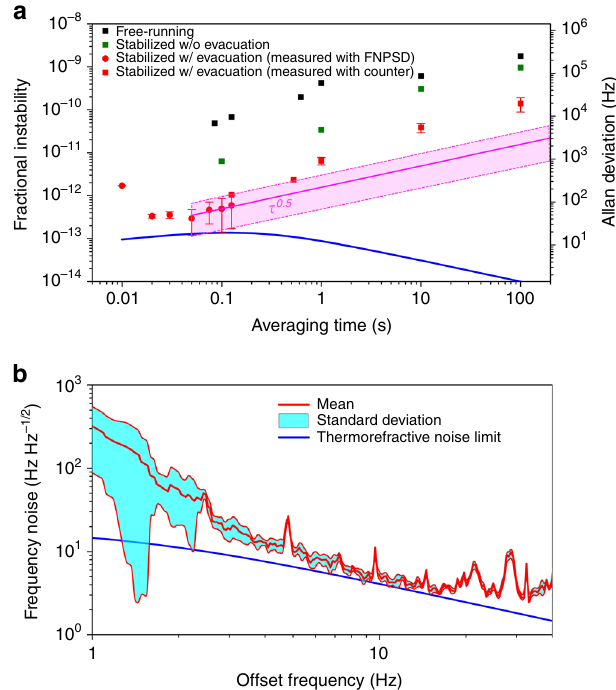
Fig. 4 Fractional frequency instability measurements. a Measured fractional frequency instabilities (FI) of the beat frequency between the Fabry-Pérot (FP) cavity reference laser and the free-running laser ( squares in black ), and the beat frequency between the reference laser and the laser stabilized to the WGM resonator without evacuation ( squares in olive ), respectively. The P n Þ and standard deviation red squares and bars are the mean ð μ ¼ n (cid:2) 1 ffiffiffiffiffiffiffiffiffiffiffiffiffiffiffiffiffiffiffiffiffiffiffiffiffiffiffiffiffiffiffiffiffiffiffiffiffiffi i ¼ 1 FI I ð σ ¼ Þ of the frequency instability of the laser stabilized to the resonator calculated from 10 sets of frequency counting data at 1 s averaging time, respectively, measured with a frequency counter where n is the number data set. The red circles and bars are μ and σ of the frequency instability of the laser stabilized to the resonator derived from the 74 frequency noise power spectral density (FNPSD) measurement traces. The magenta area represents the expected Allan deviation bound imposed by random walk frequency noise. b The noise statistics of 74 FNPSD traces. The red curve is the mean value and the cyan area is the connected standard deviations. The blue line is the thermorefractive noise limit. Both mean frequency noise and standard deviation are reduced along the offset frequency and the frequency noise reaches the thermorefractive noise limit at 6 Hz. However, the thermo-mechanical noise, induced by the residual thermal expansion, is still concentrated near the carrier causing the standard deviation of the Allan deviation measurements in